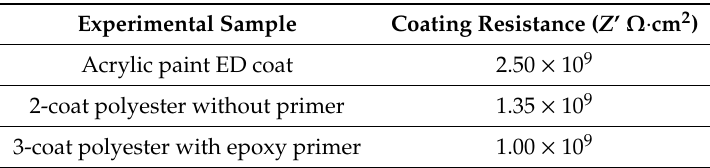
Table 4. Sample vs. Coating